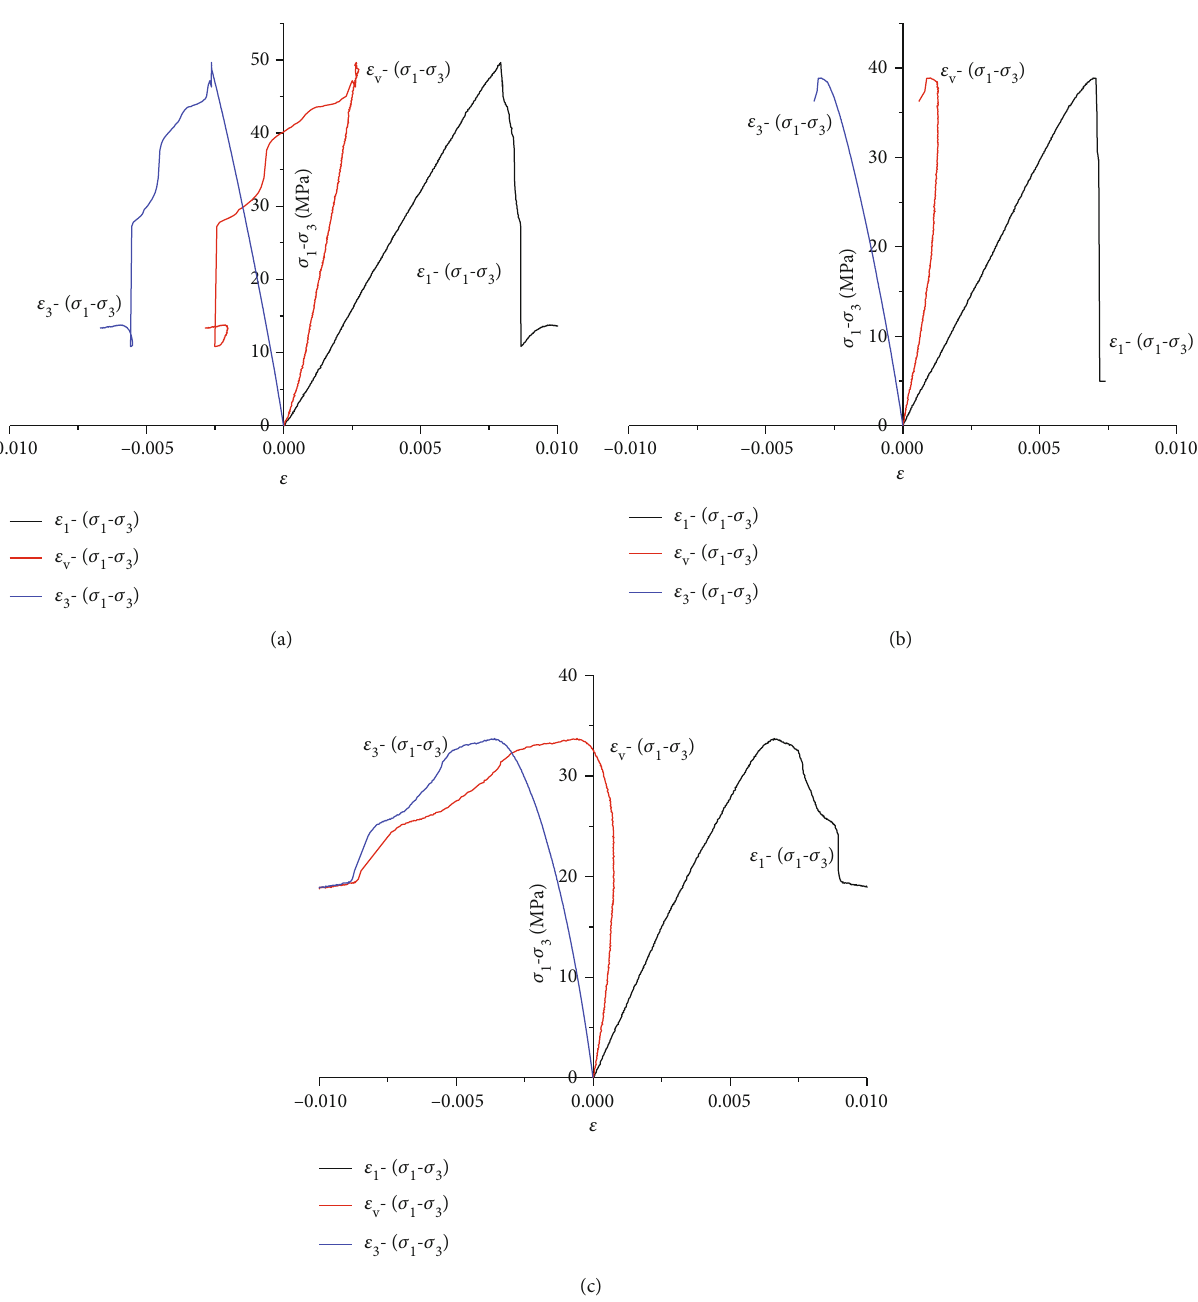
Figure 3: Triaxial test of coal samples with di ff erent